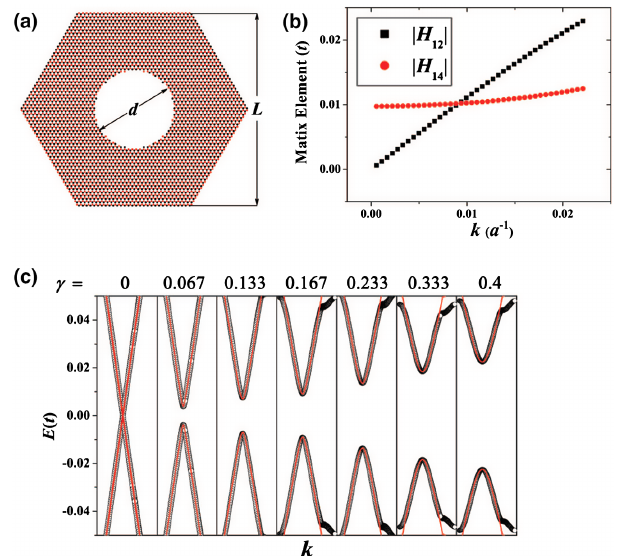
FIG. 1. (a) Antidot graphene in the tight-binding model. Red and black dots represent the carbon atoms A and B . Here, L denotes the periodicity of the antidot lattice, and d denotes the diameter of the hole. (b) The matrix element magnitude plotted as a function of Bloch wave vector k . The term j H 12 j (black solid squares) is found to vary linearly with k ¼ j k j , while the intervalley scattering term j H 14 j (red solid circles) is almost a constant. (c) Band structures for various γ with a fixed periodicity L ¼ 13 nm. The black circles represent the tight-binding results, and red curves stand for the dispersion relation given by the effective Hamiltonian. The Bloch wave vector k ranges from K to Γ , then to M, and finally back to K [here, K, Γ , and M points are for the antidot (hole) reciprocal